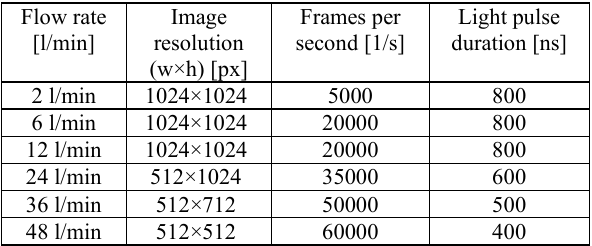
Table 1. An overview of the camera and light settings for all measured flowrates